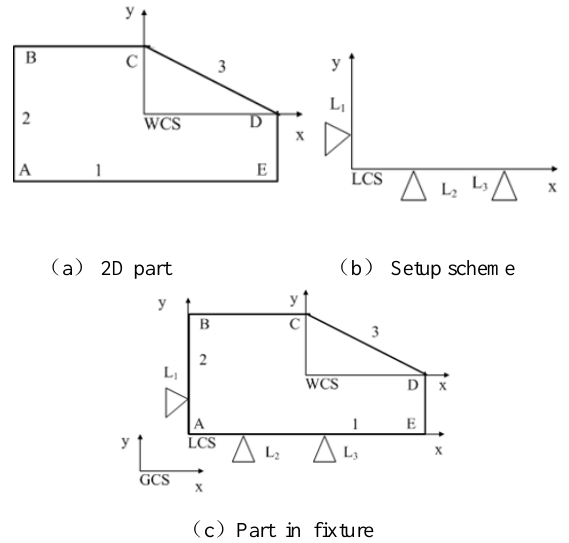
Fig 3. Simple two-dimensional example